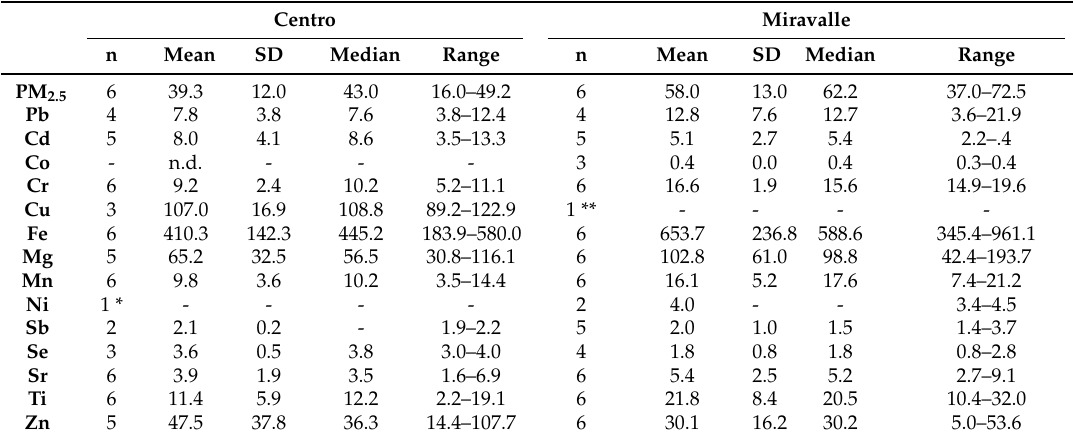
Centro Miravalle n PM